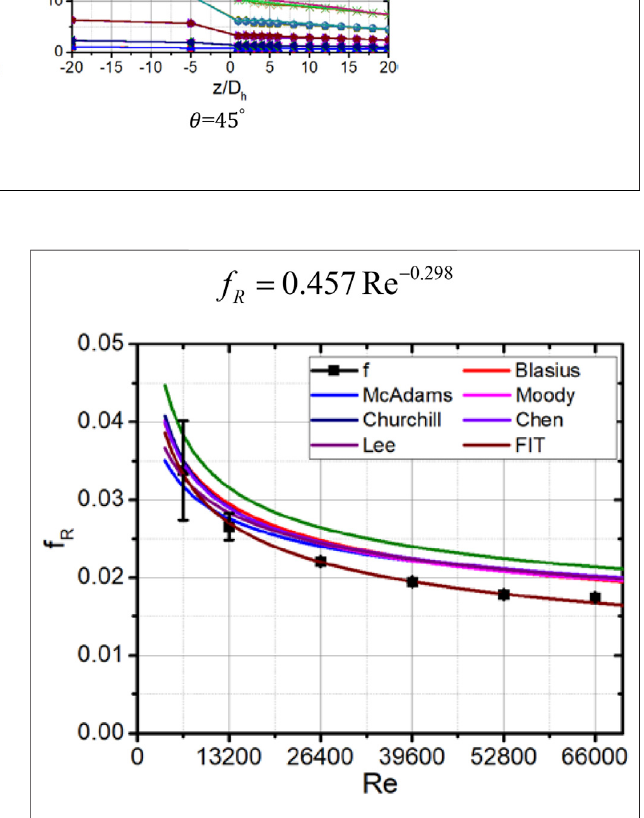
FIGURE 5 | Friction factor in the bared rod